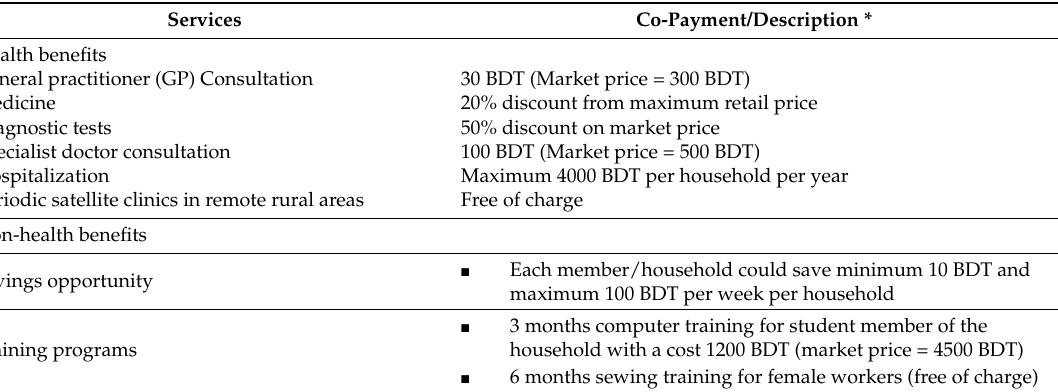
Table 1. The benefits package of the CBHI